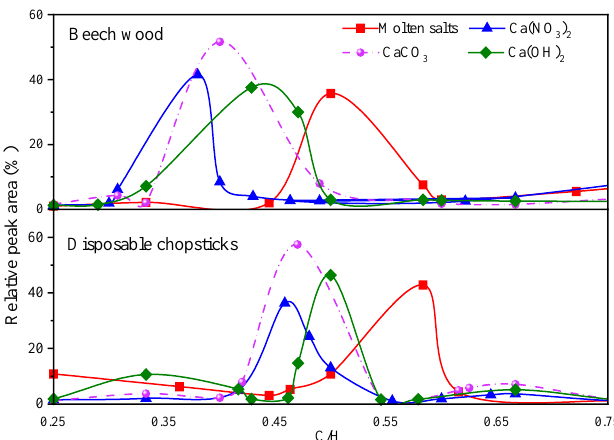
Figure 8. Effects of Ca(NO 3 ) 2 /CaCO 3 /Ca(OH) 2 on the saturation level of the liquid products.